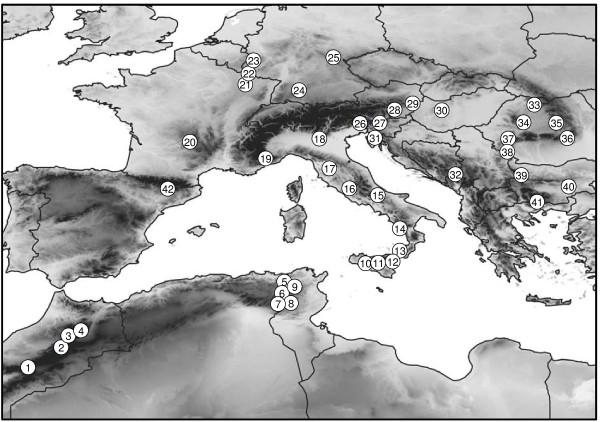
Sampling design of Melanargia galathea and M. lachesis. Geographical location of the sampled populations of M. galathea and M. lachesis (sample 42). Given numbers coincide with Table 1.